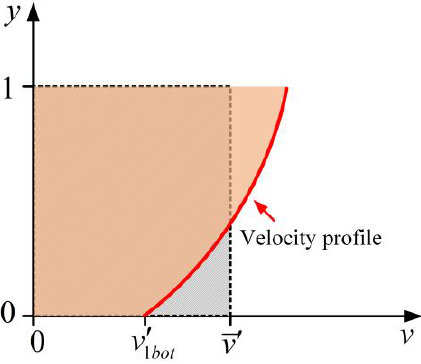
Figure 8. Diagram of relationship between base velocity and mean velocity.